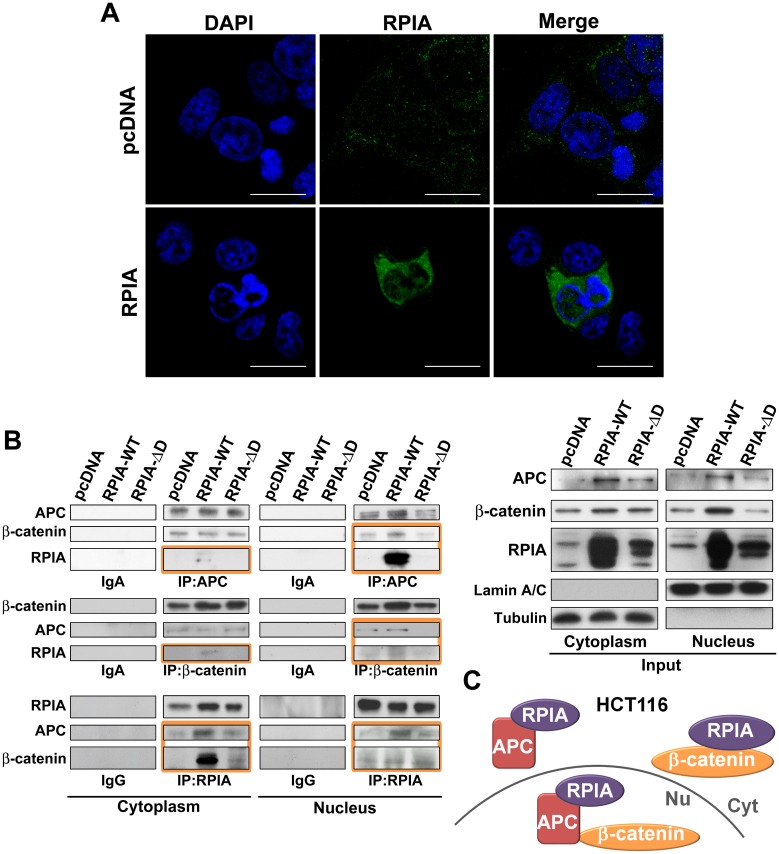
RPIA localizes in the nucleus and interacts with APC and β-catenin in HCT116 cells.(A) Nuclear localization of RPIA was detected by immunostaining with an anti-RPIA antibody (green) in HCT116 cells with and without overexpression of RPIA. DAPI was used to counterstain nuclei (blue). Scale bar: 50 μm. (B) Left panels: The cell lysates were precipitated by anti-APC, anti-β-catenin, and anti-RPIA antibodies in HCT116 cells. The APC, β-catenin, and RPIA interaction can be increased by RPIA-WT but not by RPIA-ΔD. Right panels: Protein loading input for IP assay of HCT116 cells. The orange boxes indicate the signals were enhanced by RPIA-WT but not in RPIA-ΔD. (C) Model of RPIA-β-catenin-APC interaction in HCT116 cell line. APC, adenomatous polyposis coli; Cyt, cytoplasm; IgA, immunoglobulin A; IP, immunoprecipitation; pcDNA, pcDNA3 vector control; Nu, nucleus; RPIA-ΔD, RPIA deletion domain D mutant; RPIA, ribose-5-phosphate isomerase A; RPIA-WT, RPIA wild type.